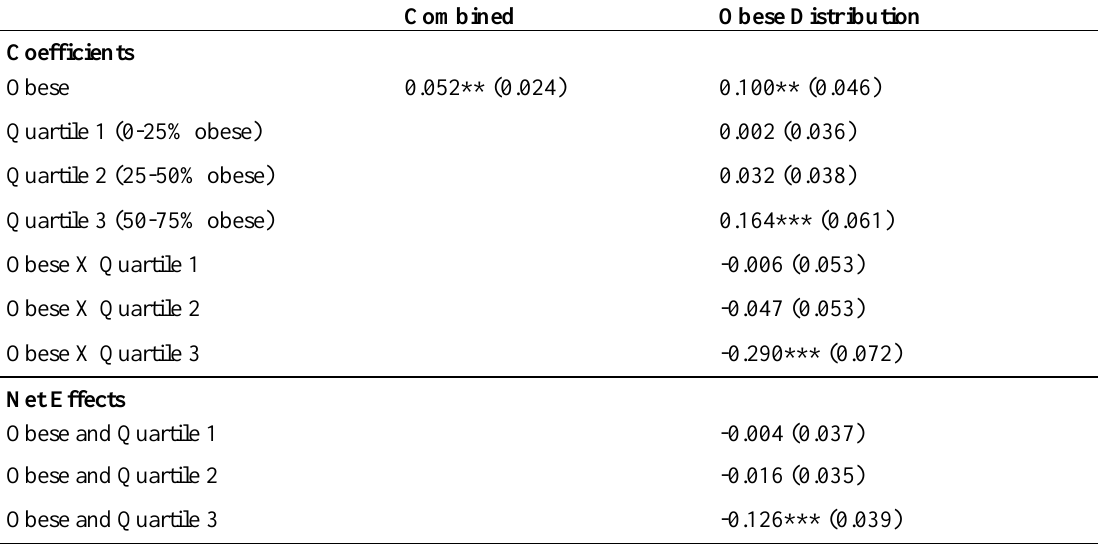
Table 5: Estimated wage effects of workgroup composition among